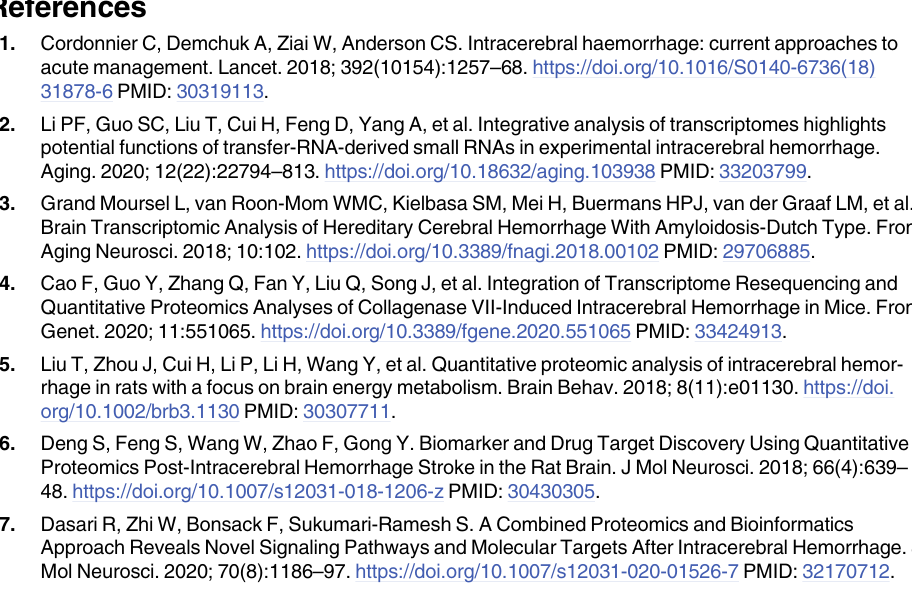
S1 Table. The information of identified succinyllysine sites in this study. S2 Table. The category information of significantly altered succinylated proteins in the ICH brains according to their ratio of